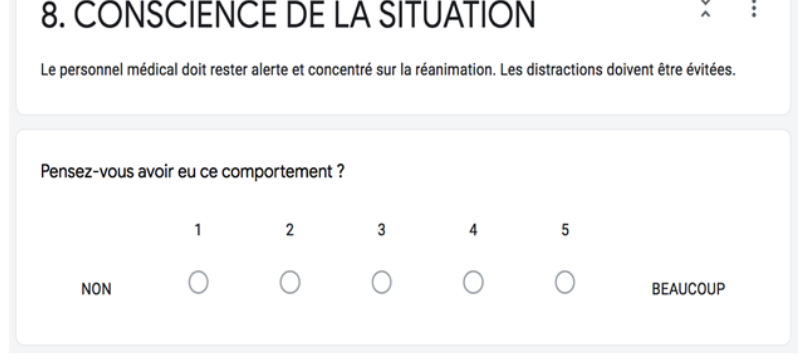
Figure 4. Self-debriefing of nontechnical